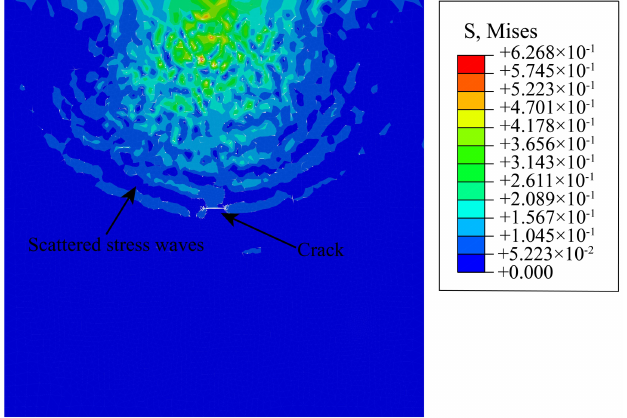
Figure 5. Wavefield of the model with a crack simulated with ABAQUS at 0.1 ms ( θ = 0 ◦ , L = 2 mm).